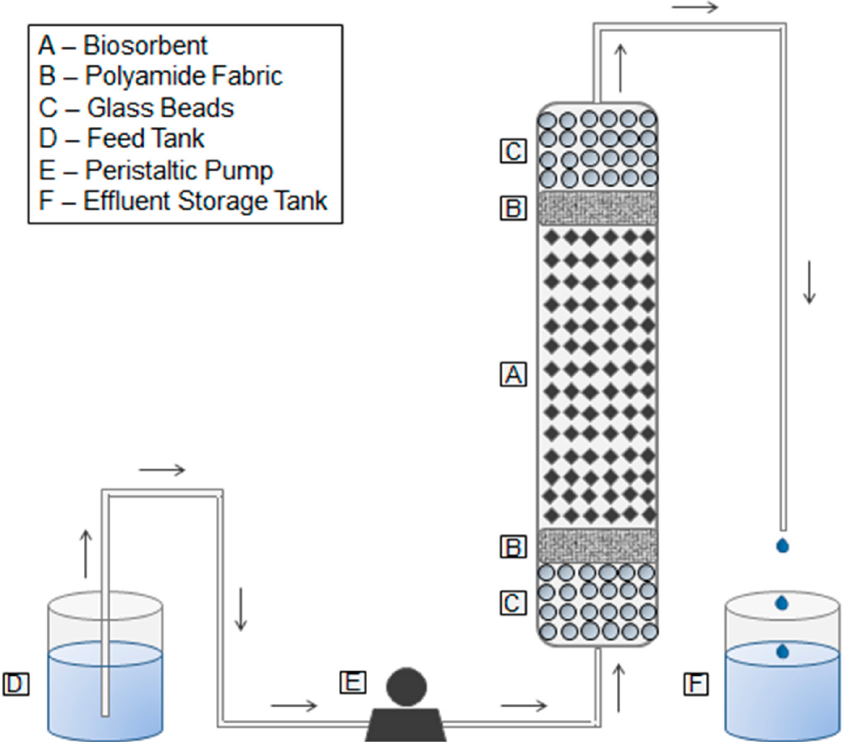
Figure 1. Schematic diagram of the lab-scale packed-bed column for adsorption.